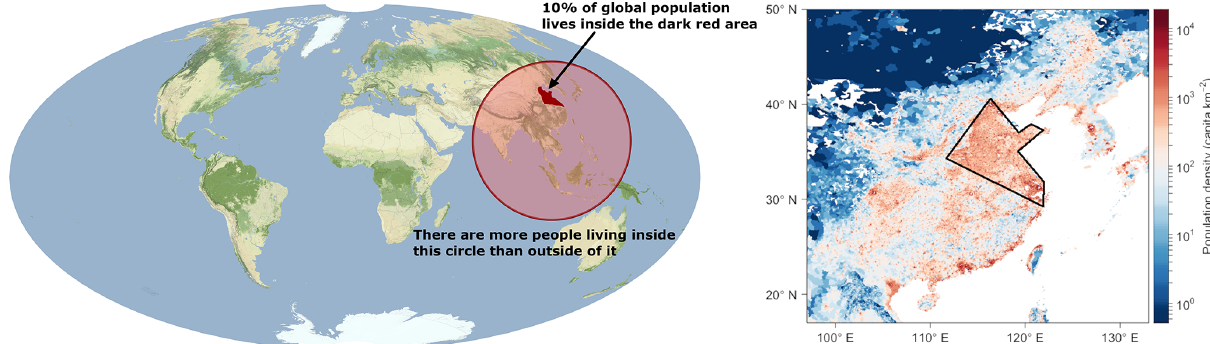
Figure 2. Population density map, including the gigacity in eastern China. Half of the population of the world lives inside a circle that covers China, India and the South East Asian peninsula. Approximately 10% of the world’s population lives inside the triangle. This region is the most important economic driver of the world’s economy, and the GDP, particularly in this gigacity, has increased very rapidly during the last few decades. The data are obtained from Stamen Design (CC-BY 3.0) and the Gridded Population of the World (GPW v4.11; CC-BY 4.0; CIESIN,